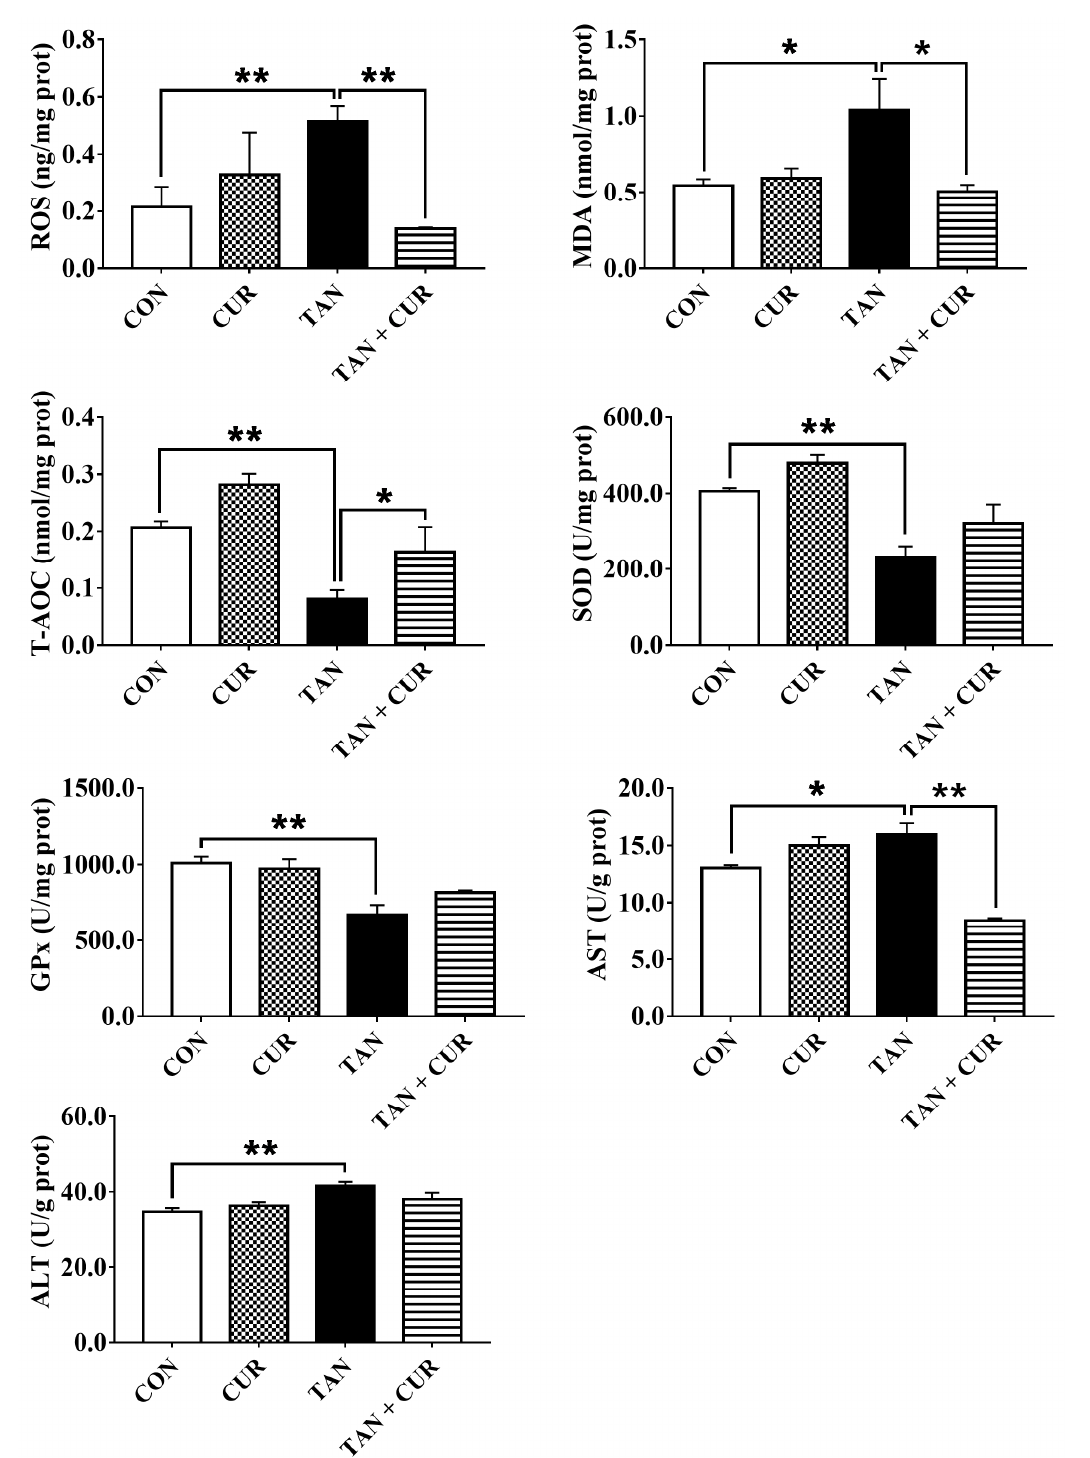
Figure 2. Changes in liver metabolites in gibel carp after eight weeks of feeding CUR diets followed by acute ammonia stress. CON—control; CUR—curcumin; TAN—total ammonia nitrogen; TAN + CUR—total ammonia nitrogen + curcumin. ROS—reactive oxygen species; MDA—malondialde- hyde; T-AOC—total antioxidant capacity; SOD—superoxide dismutase; GPx—glutathione peroxi- dase. The values are expressed as the mean ± standard error ( n = 6). * p < 0.05; ** p < 0.01.